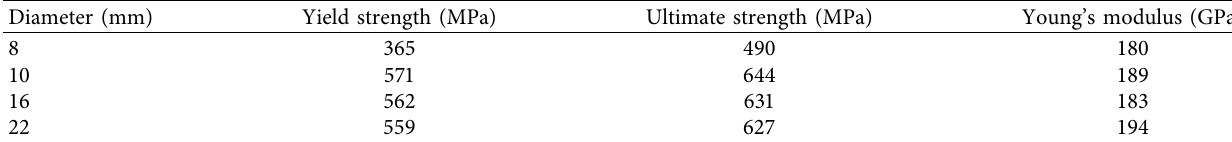
Table 3: Reinforcement material properties.